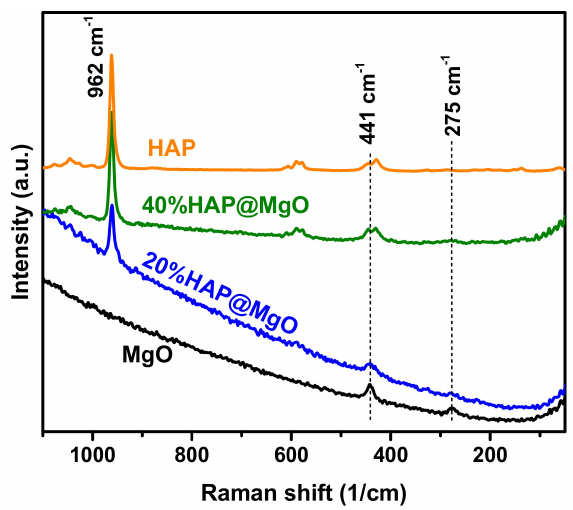
Figure 2. Raman spectra of the two references MgO and commercially available HAP, compared with that of the HAP@MgO composites.